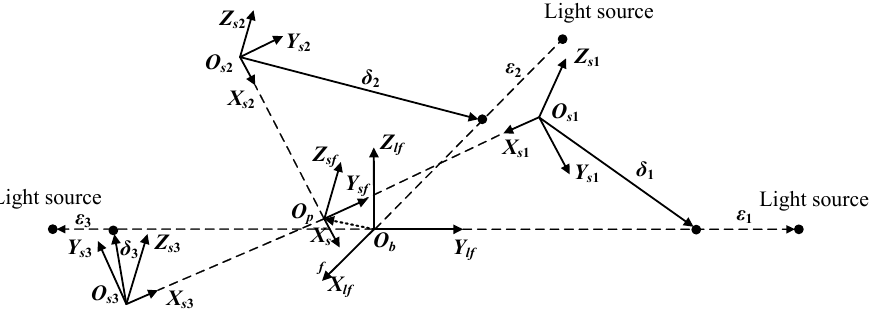
Figure 9. Coordinate system for six-dimensional position and orientation measurement model.